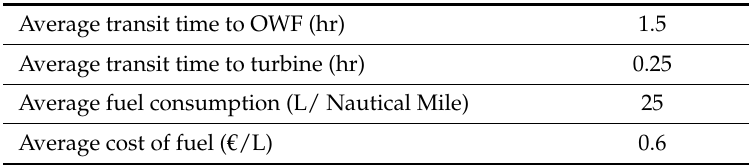
Table 11. Average transit times and cost.